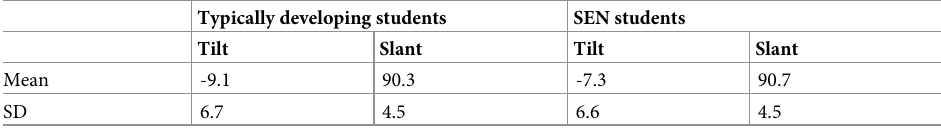
Table 3. Means and standard deviations of the students’ handwriting.